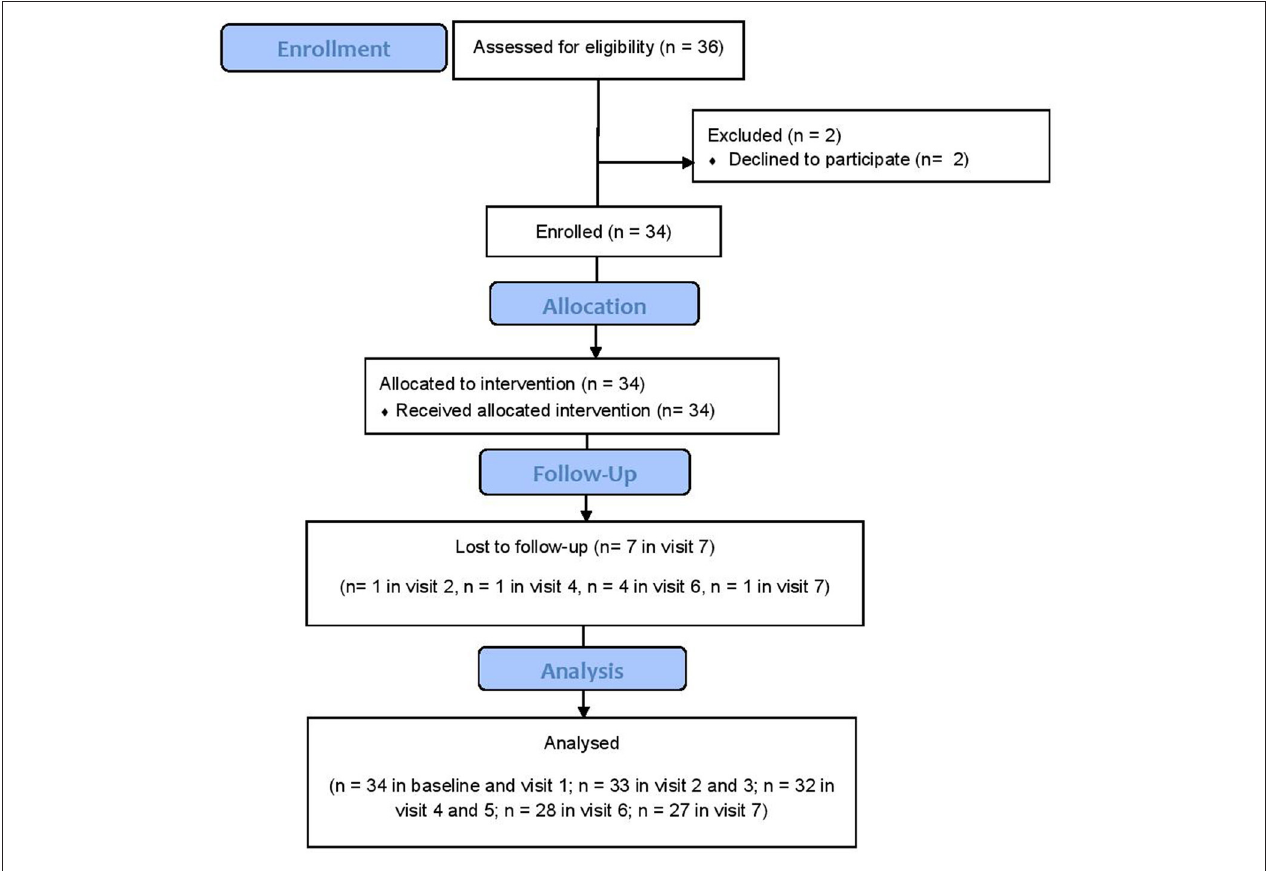
FIGURE 1 | CONSORT flow diagram of the